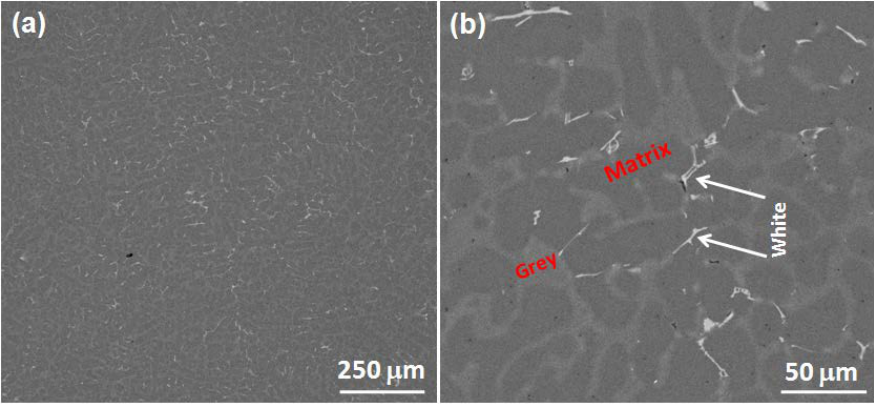
Figure 15: The BSE SEM microstructures of cross section of the base of the antenna: (a) low and (b) high